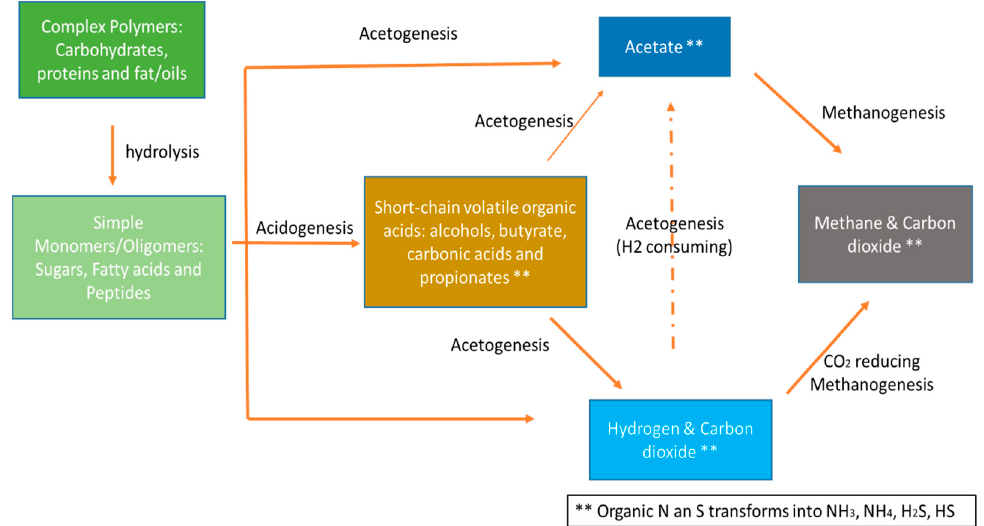
Figure 2. Biological Processes during Anaerobic Digestion of Sludge (based on information from [11]).